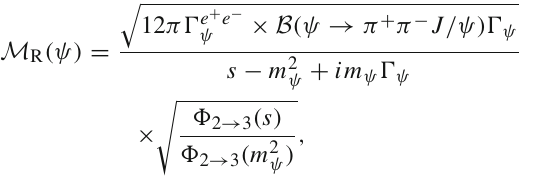
Fig. 2 Our fittothecross sectionfor the e + e − → π + π − J /ψ process measured by the Belle [8] and BESIII collaborations [12] under the 2R and 3R fit schemes. Here, both the BES and Belle data are included in the present fit (color